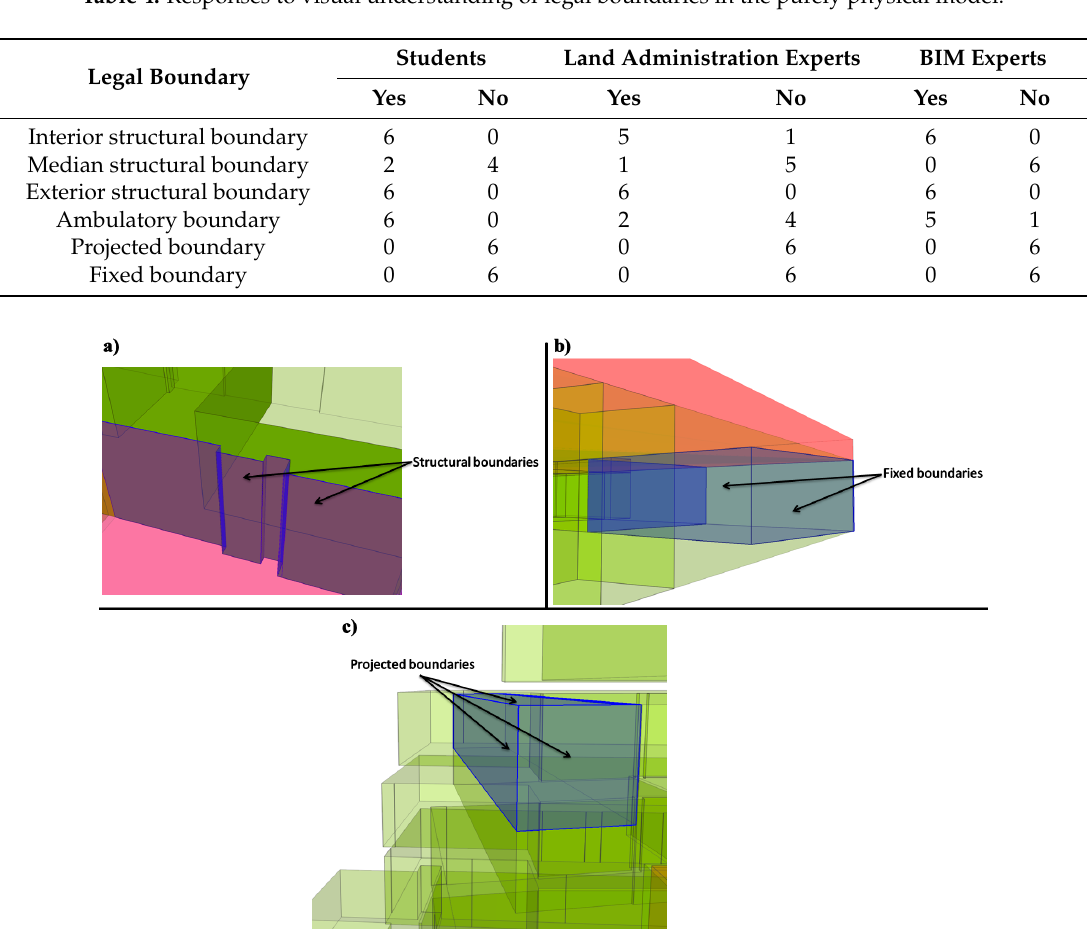
Figure 11. Examples of legal boundaries represented in the purely legal model: ( a ) Structural boundaries; ( b ) Fixed boundaries of a parking space; ( c ) Projected boundaries.